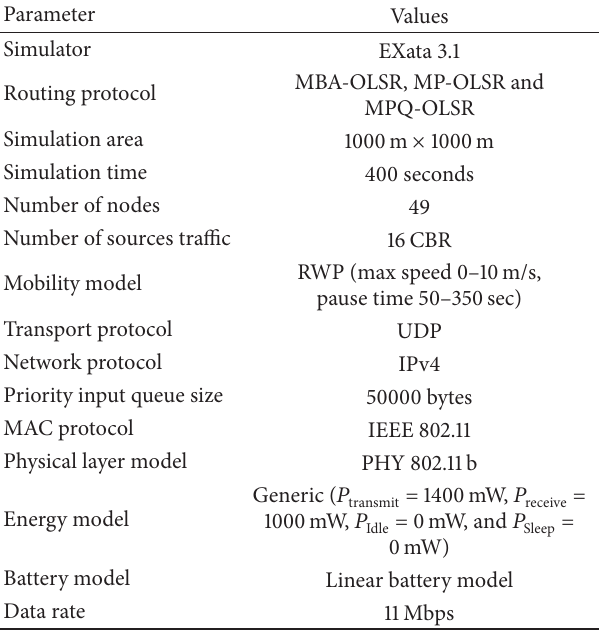
Table 1: Simulation parameters.